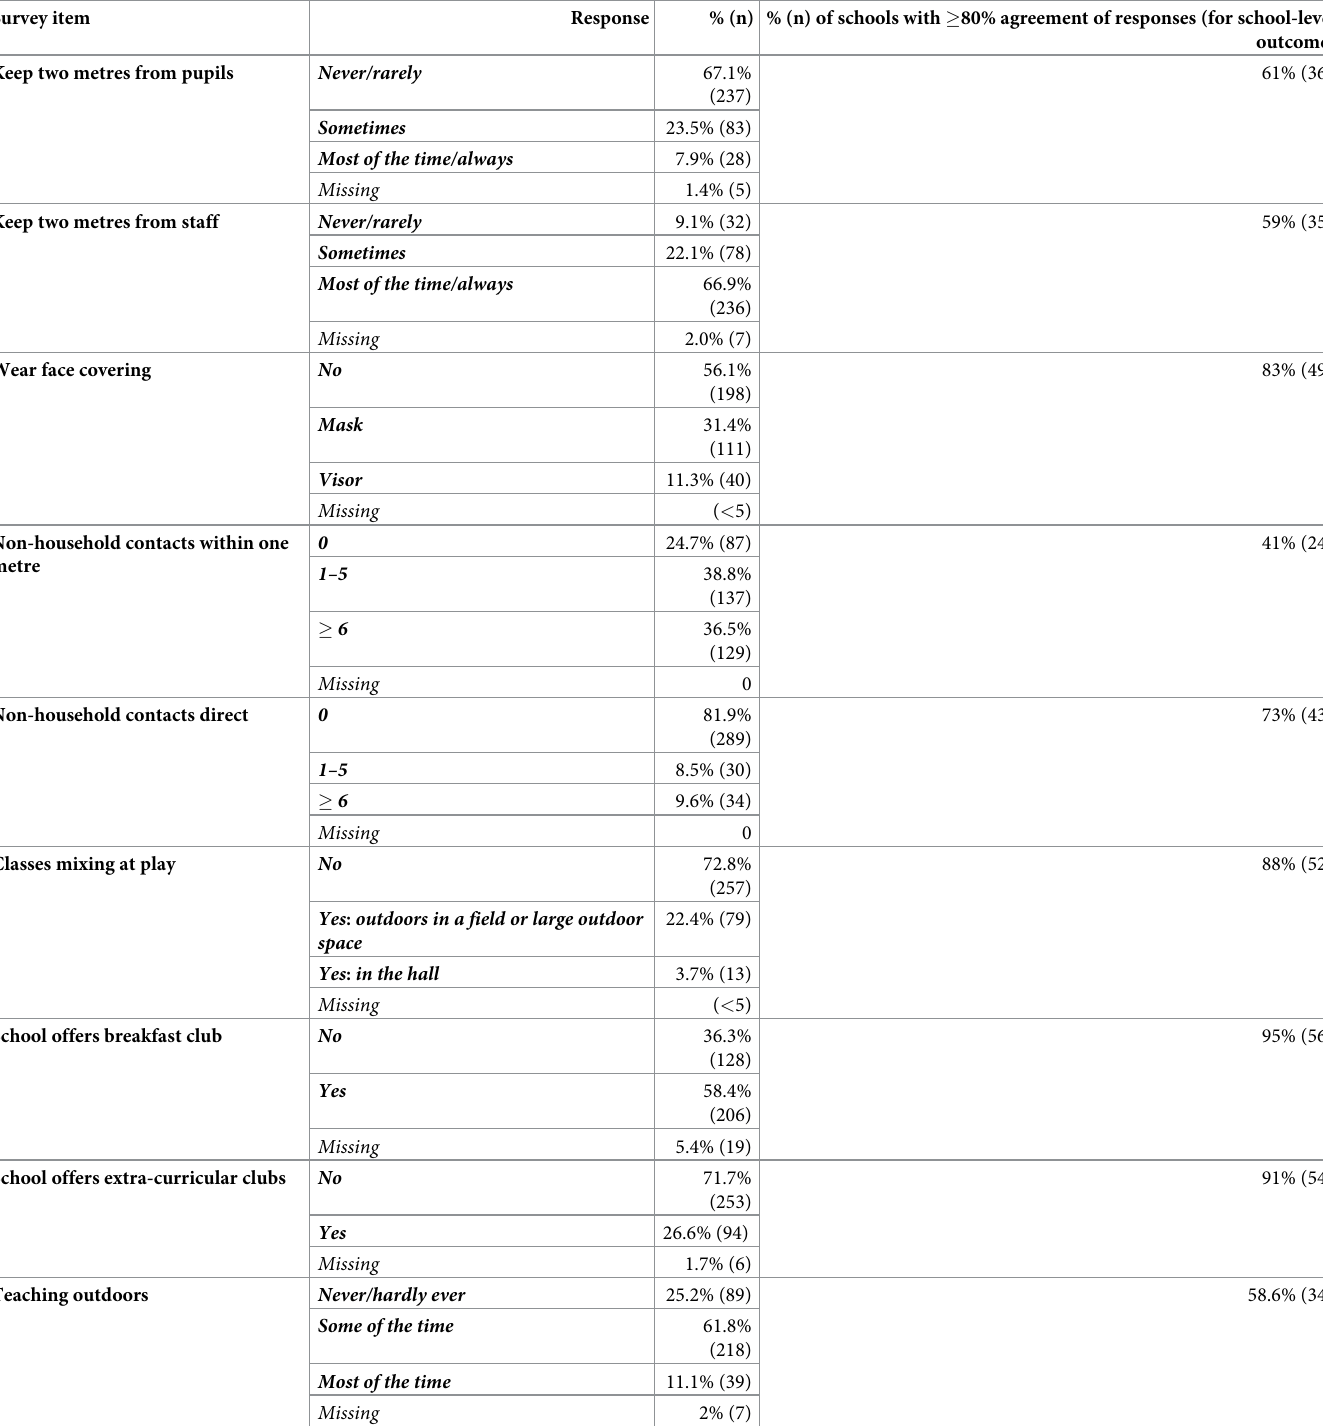
Table 2. Distribution of individual school staff responses to mitigation survey items and school-level response agreement (see S3 Appendix). Survey